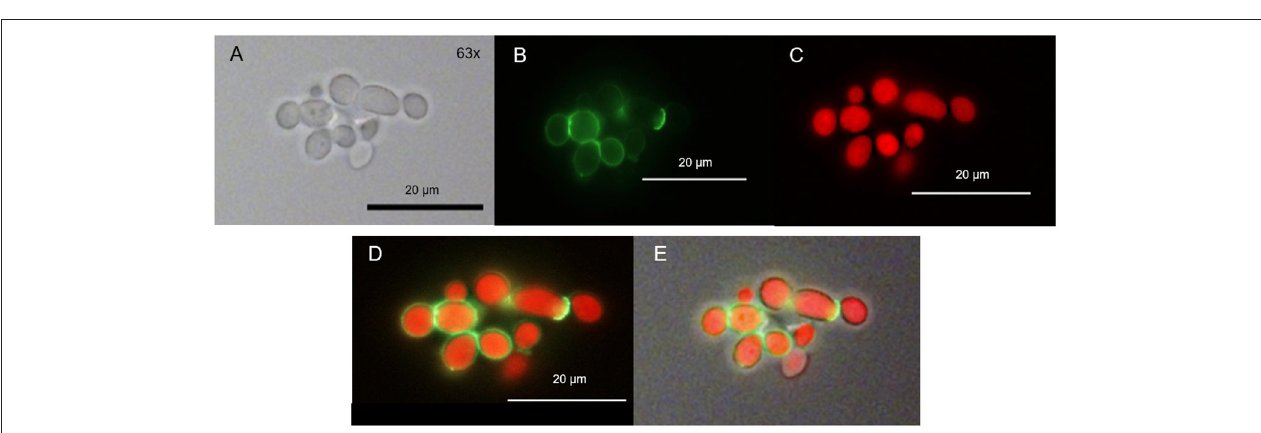
FIGURE 6 | Spatial distribution of TMPyP in C. albicans after irradiation. C. albicans cells incubated with TMPyP (1 µ M) were irradiated with blue light (12 J/cm 3 ). Fluorescence microscopy revealed some ring-shaped configurations of TMPyP corresponding to the cell wall ( A2 , → ). Most of the cells showed TMPyP-fluorescence from the area of the cytoplasm. This indicates that TMPyP delocalizes from the cells’ periphery to the cells’ interior upon photodynamic action. C. albicans cells incubated with TMPyP imaged with brightfield microscopy (A1, B1) , fluorescence microscopy (A2, B2) , and brightfield and fluorescence micrographs overlayed (A3, B3) .